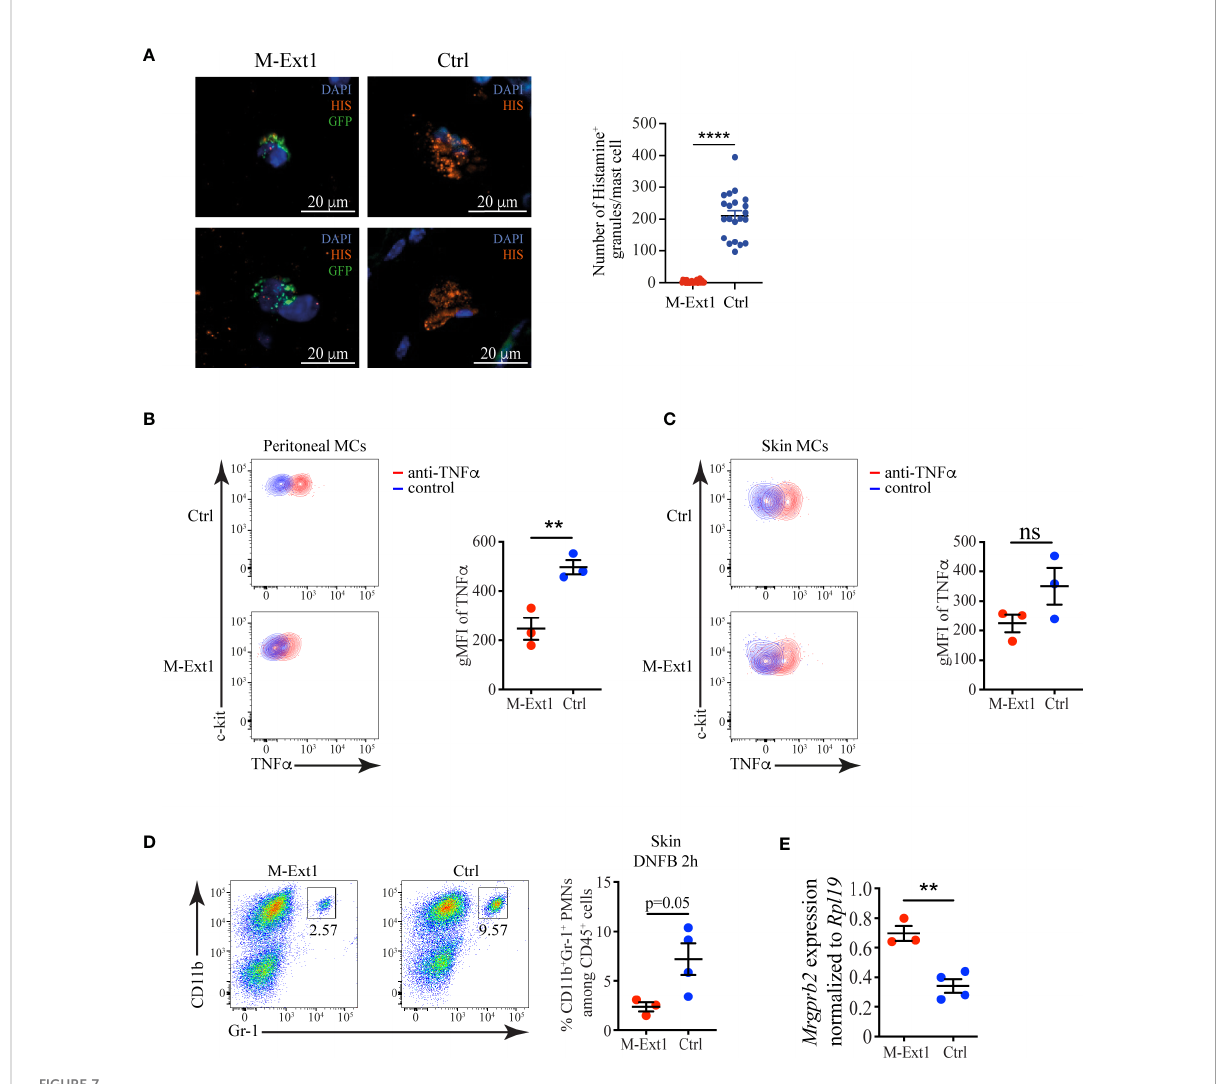
FIGURE 7 Reduced levels of Histamine and TNF a , but an enhanced expression of Mrgprb2 in Heparin-de fi cient mast cells. (A) Immuno fl uorescent staining for Histamine of skin sections from M-Ext1 crossed to ROSA26 LSL-GFP and control ( Ext1 f/f ) mice and quanti fi cation of the number of Histamine + granules in skin mast cells from both genotypes. Histamine + granules were counted in 3-4 fi elds of view from sections from three different mice per genotype. (B) Flow cytometry plots showing TNF a expression in peritoneal mast cells and comparison of the geometric mean fl uorescent intensity (gMFI) between M-Ext1 and control peritoneal mast cells. (C) Flow cytometry plots showing TNF a expression in skin mast cells and comparison of the geometric mean fl uorescent intensity (gMFI) between M-Ext1 and control skin mast cells. (D) Flow cytometry plots showing the abundance of CD11b + Gr1 + monocytes 2 h after DNFB application on the ears of M-Ext1 and control mice. The numbers inside the fl ow cytometry plots are the percentages of neutrophils among CD45 + hematopoietic cells. (E) Mrgprb2 mRNA expression determined by qPCR from sorted skin MCs from M-Ext1 and control mice. Results are represented as mean ± SEM from 3-4 mice of each genotype. Each symbol in the graphs is an individual mouse. Statistical signi fi cance was determined by unpaired Student ’ s t-test. Values of p<0.05 were considered statistically signi fi cant, **p < 0.01, ****p < 0.0001, ns, not signi fi